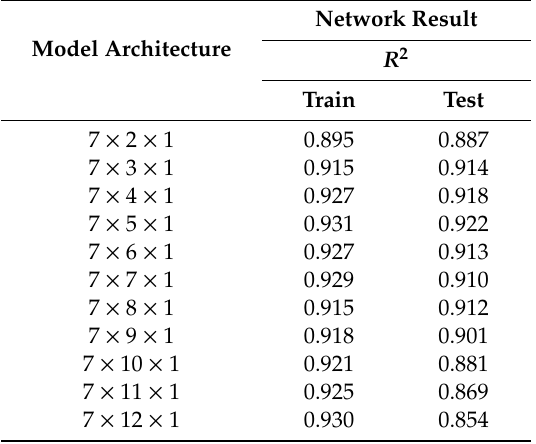
Table 2. Testing the di ff erent architectures of ANN with their R 2 .